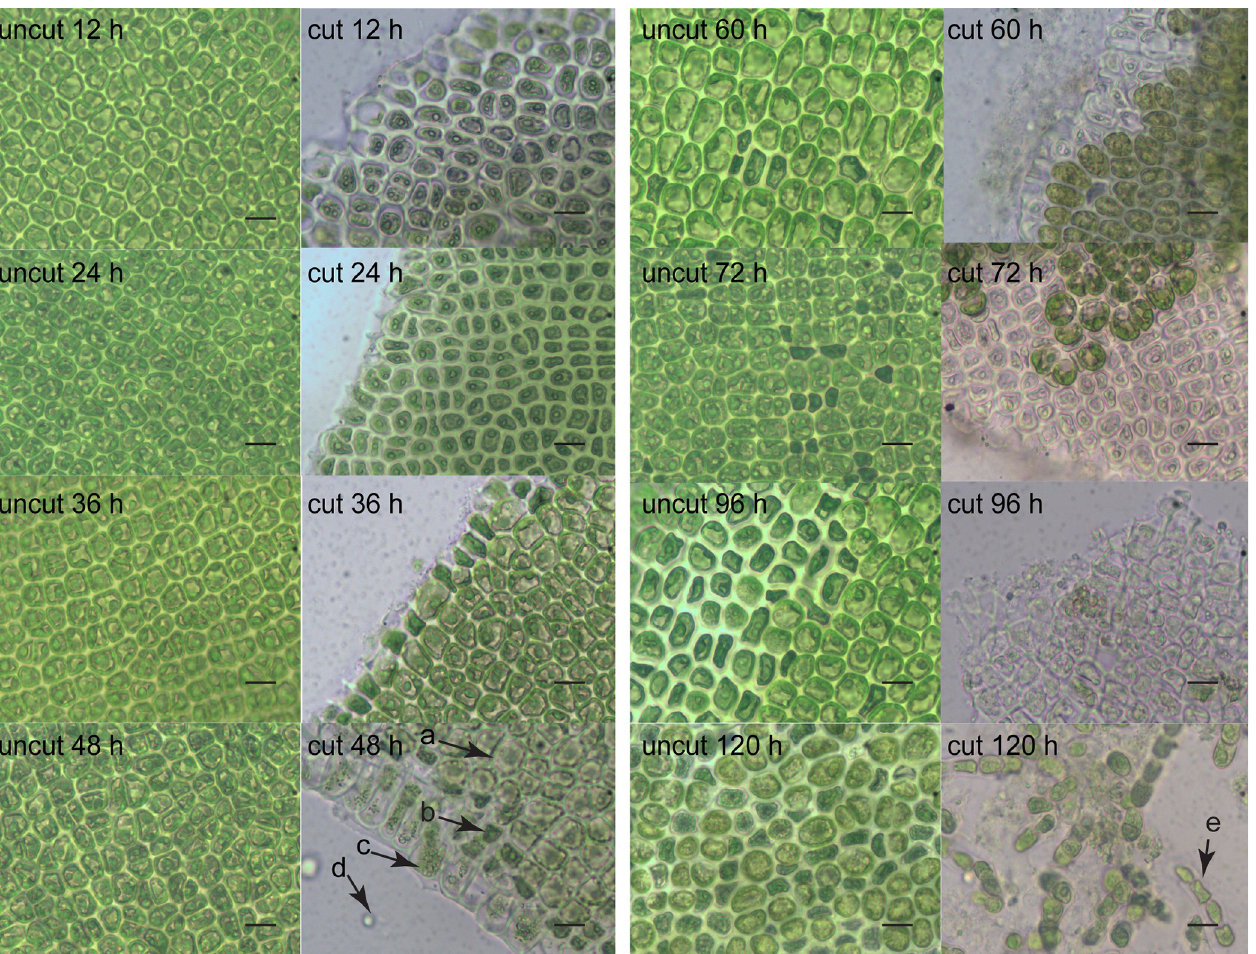
Fig 1. Microscopic observation of the transformation of U . prolifera from the vegetative state to the reproductive state after cutting. Left: uncut(control); right: cut (treatment) 12, 24, 36, 48, 60, 72, 96, and 120 h. For 48 h of treatment: a, b, c, d, represent vegetative cell, mature germ cell sac, released germ cell sac, and released gametophytes/sporophytes respectively, for 120h of treatment: e represents germinated seedling, the scale bars represent 20 μ m.